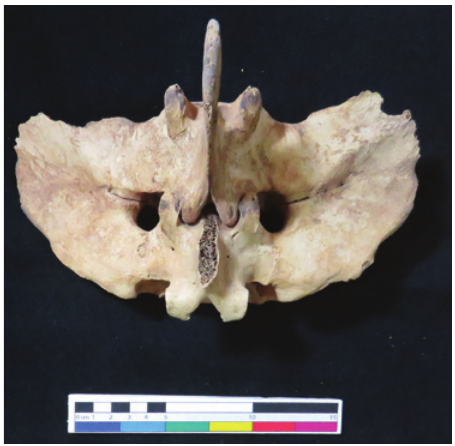
Figure 6 Fused lumbar vertebrae L5–L6 of Ku. 209. (Image credit: Giulia